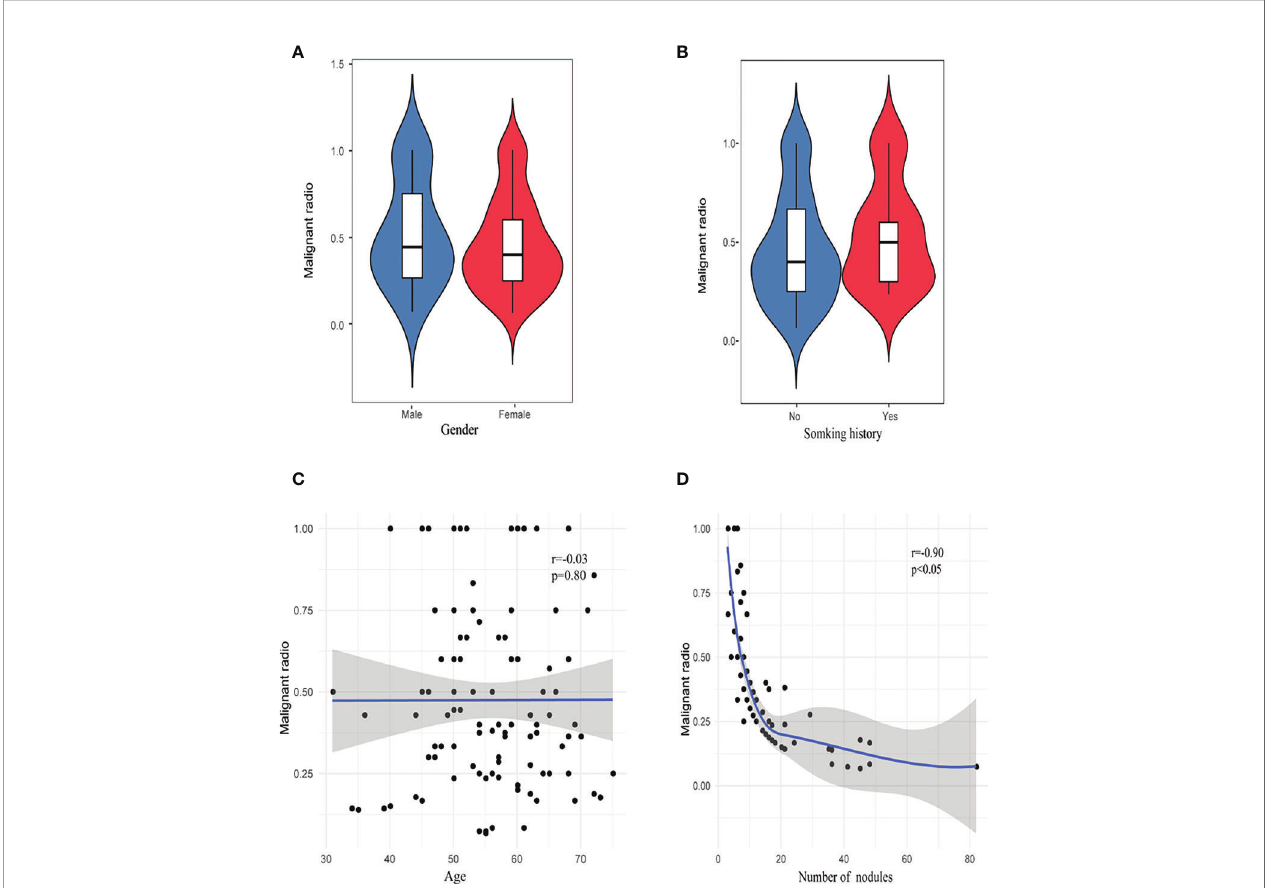
FIGURE 4 | Risk factor analysis of malignant rate. (A) Gender, (B) smoking history, (C) age, and (D) number of